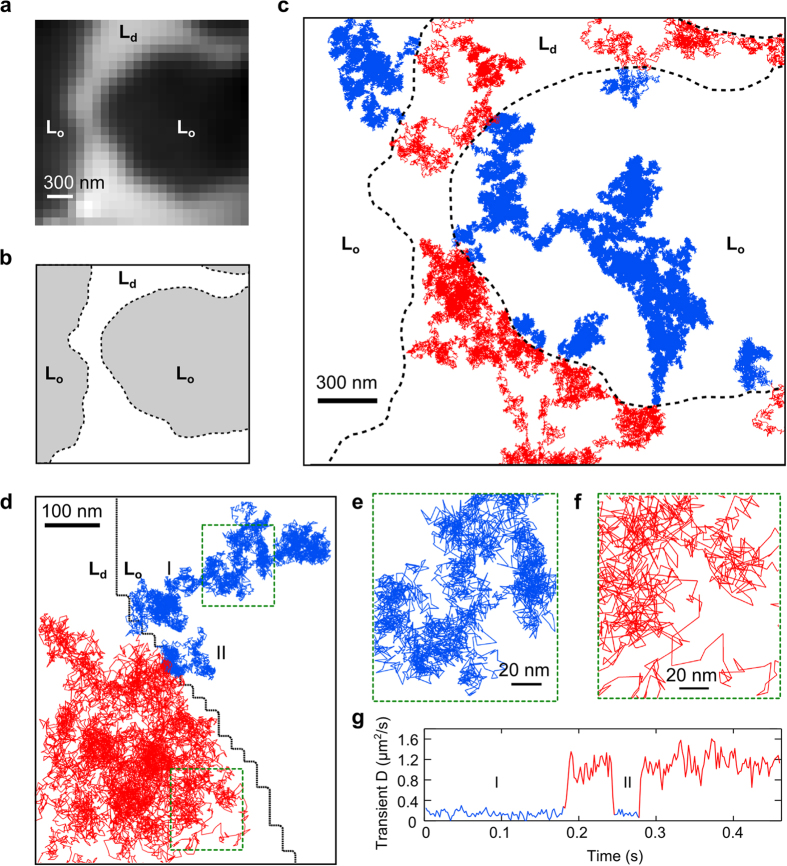
Continuous observation of single lipid molecule diffusion in raft-containing membrane at 50 kHz.(a) Fluorescence raw image of micron-sized raft-mimetic Lo domains (appear as dark areas) in the membrane. (b) Areas of the Lo and Ld domains defined from the fluorescence image. (c) Ten representative diffusion trajectories of single lipid molecules in the raft-containing membrane recorded at 50 kHz where each of them explores both the Ld and Lo domains. The parts of trajectories in the Ld and Lo domains are colored in red and blue respectively, while the domain boundaries are marked by the dashed lines. (d) A segment of diffusion trajectory of a lipid molecule repeatedly leaving from and entering the raft domain (see Movie S2). Domain boundary is plotted as the black line. The lipid was initially in the Lo domain (marked as I); it left the Lo domain and re-entered the Lo domain shortly (marked as II), and it left the Lo domain again at the end. (e,f) Close-up views of the trajectory shown in (d), in the Lo domain (e) and in the Ld domain (f) respectively, showing distinct diffusion behaviors. (g) Transient diffusion rate of the lipid calculated from the trajectory in (d). The diffusion rates in the Lo and Ld domains are very different: slow diffusion of 0.13 μm2 s−1 and fast diffusion of 1.19 μm2 s−1 were measured in the Lo and Ld domains respectively.